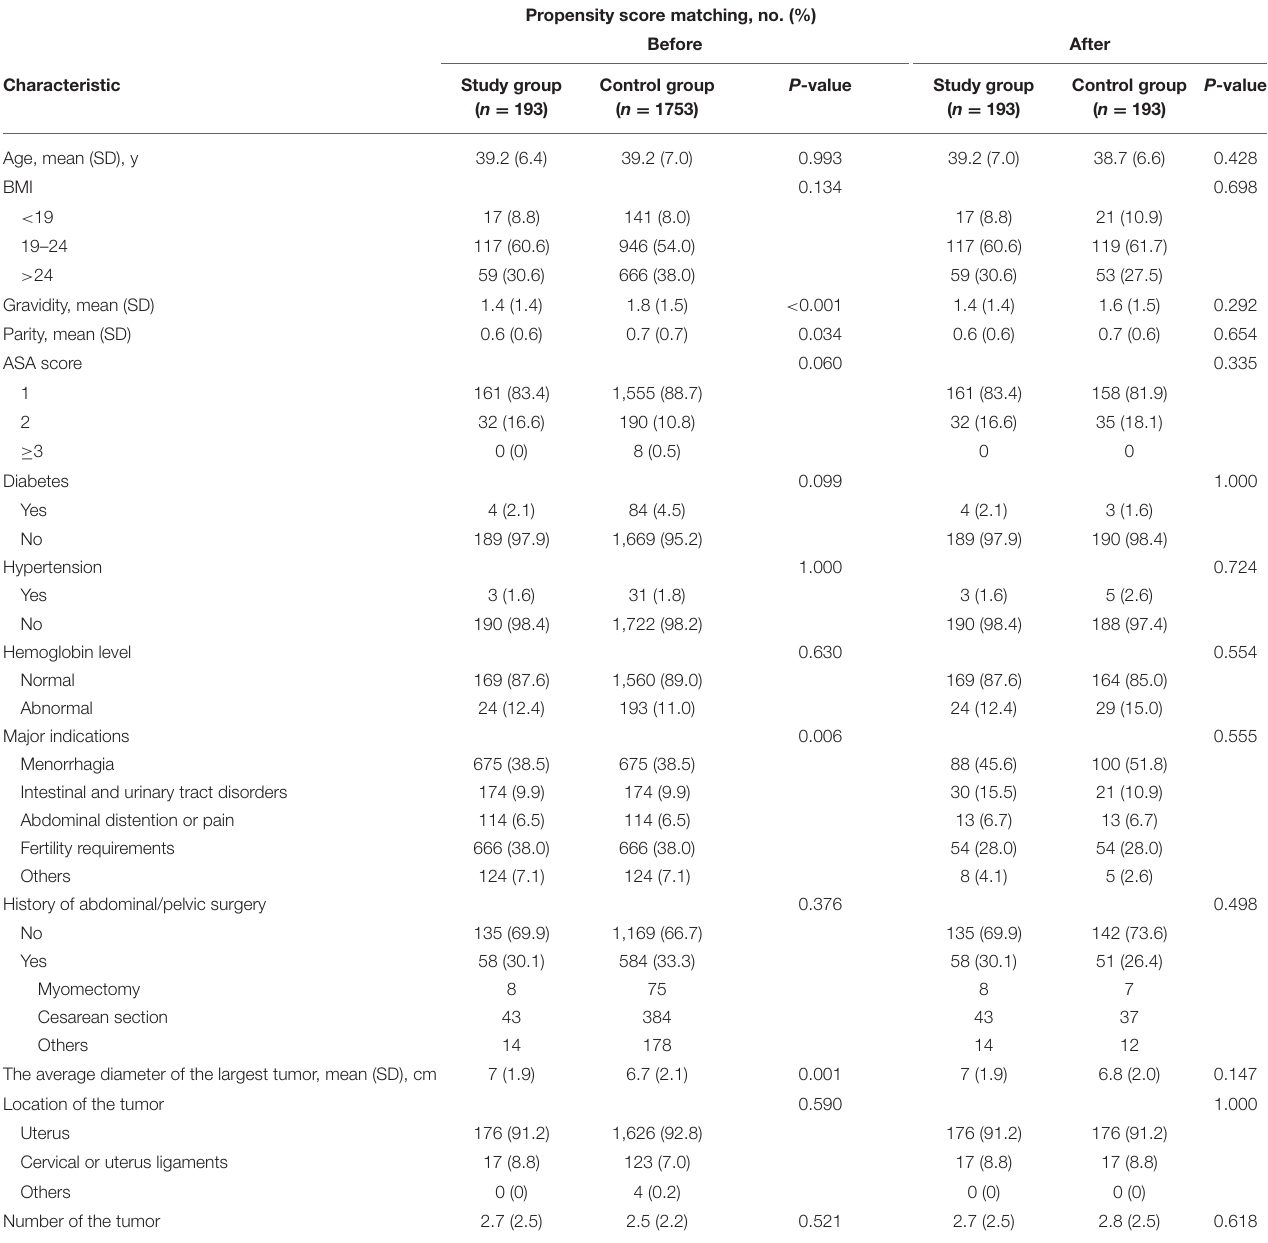
TABLE 1 | Patient characteristics before and after propensity score matching.